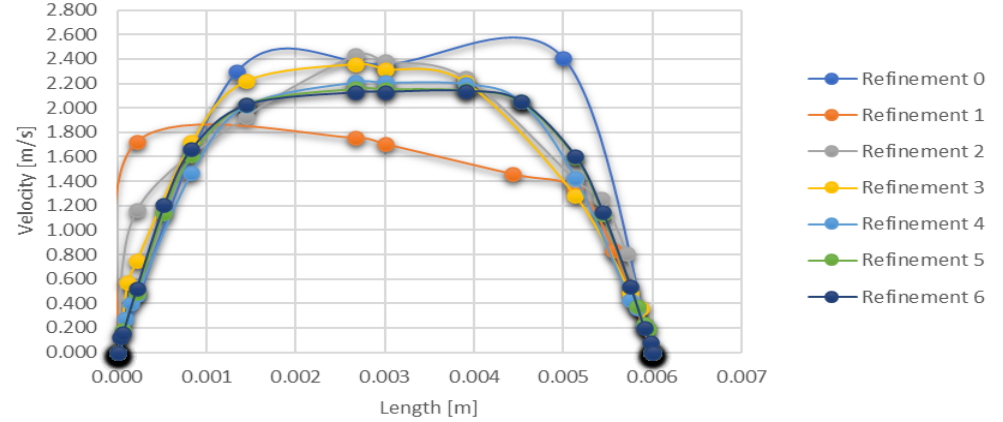
Figure 5. Velocity versus length for different mesh refinements for geometry with lateral air inlet and outlet.